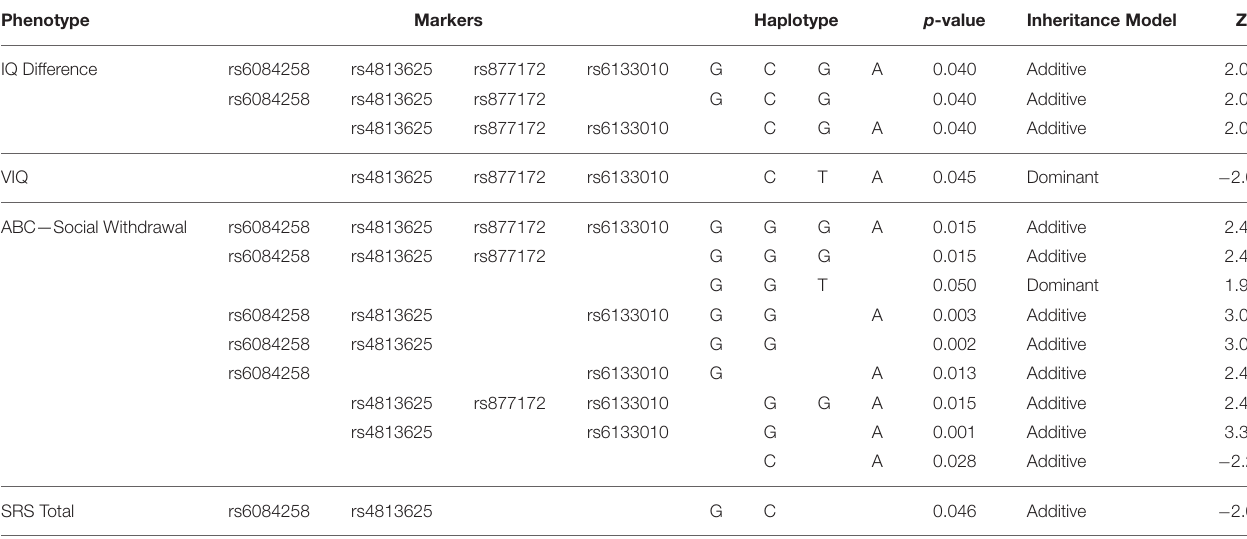
TABLE 3 | Haplotype associations in the entire